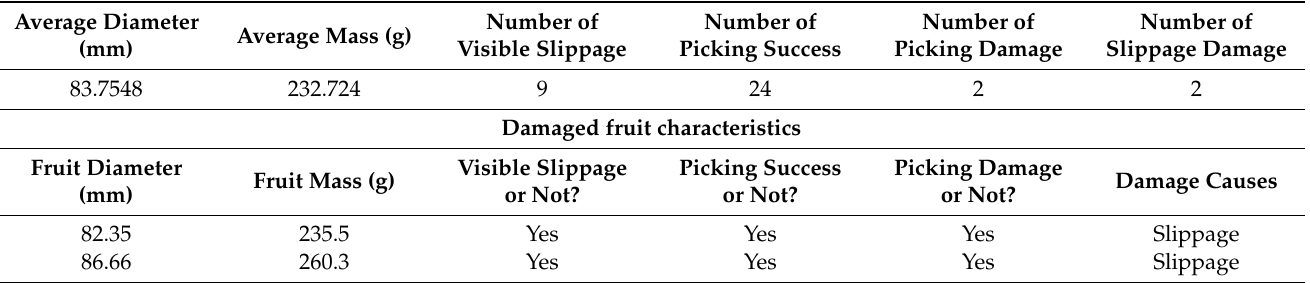
Table 3. The harvesting situation of soft fingers without slip detection.